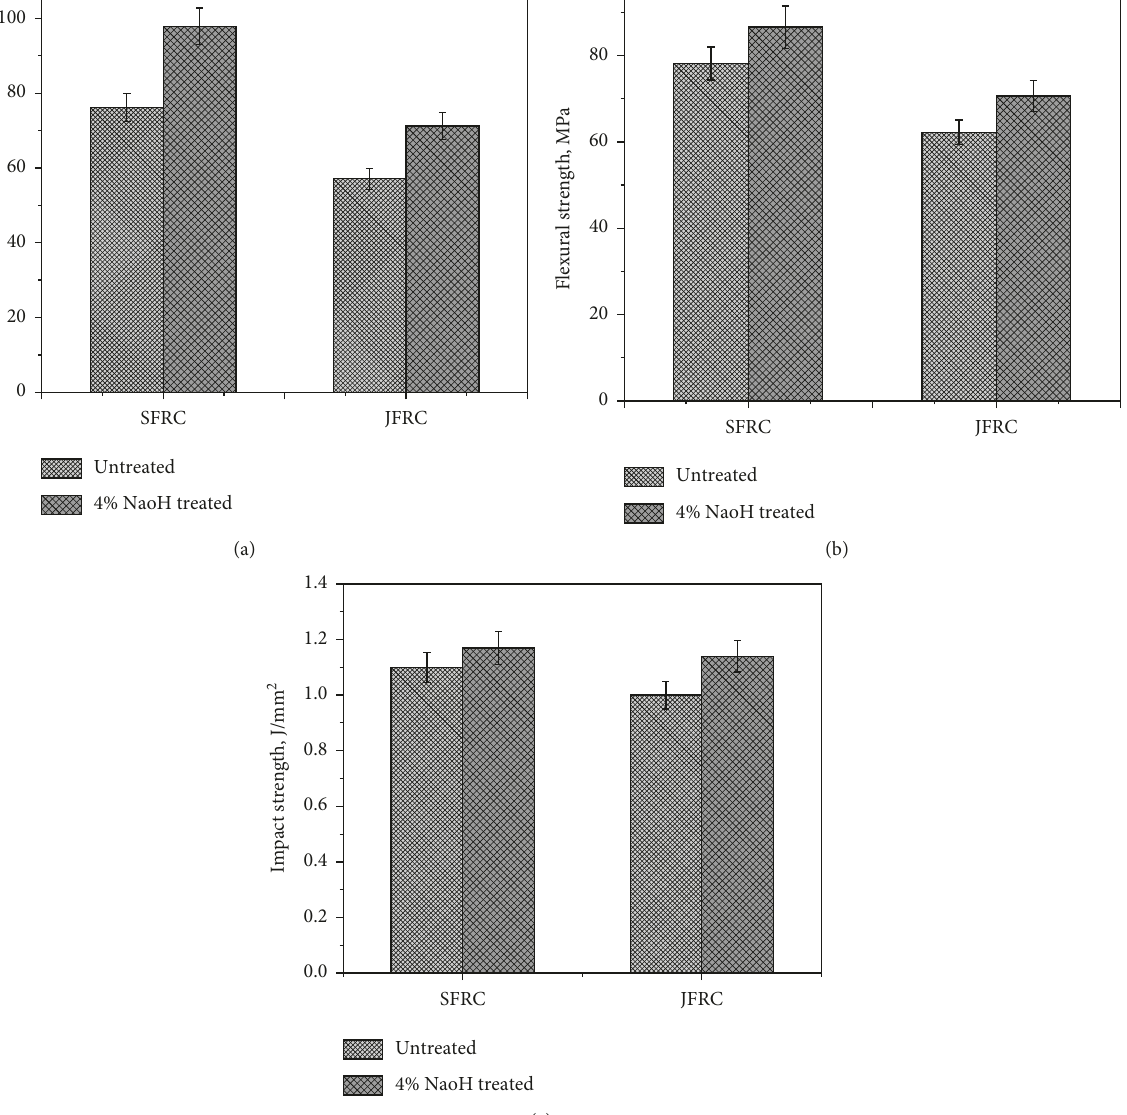
Figure 8: Characteristics of SFRC and JFRC. (a) Tensile strength. (b) Flexural strength. (c) Impact